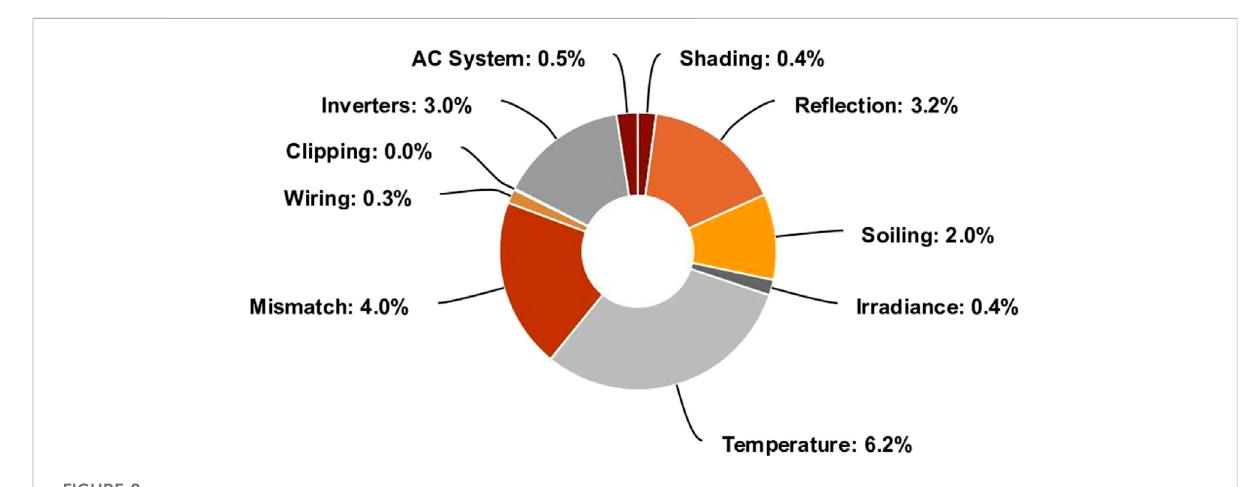
FIGURE 8 Major photovoltaic system